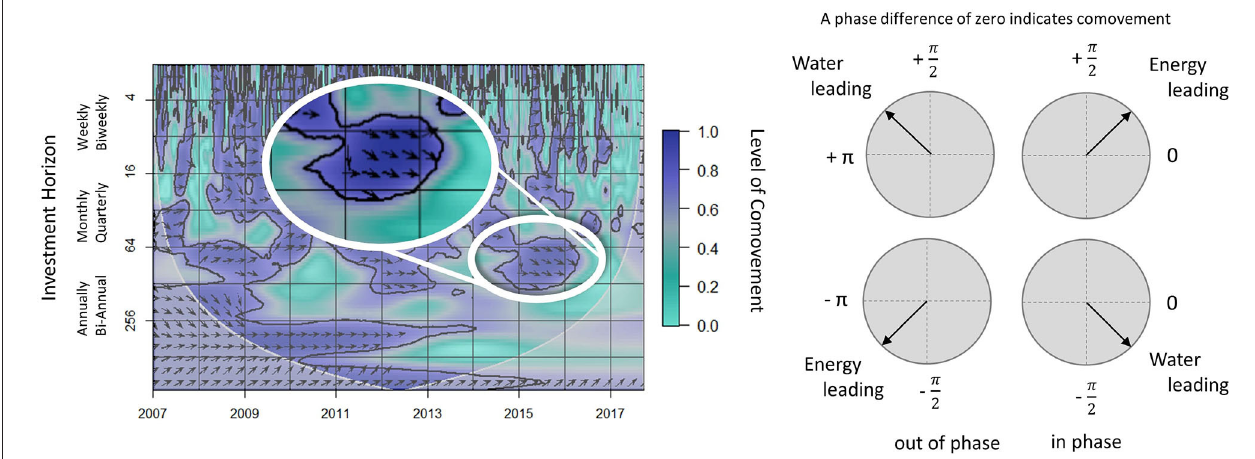
FIGURE 2 | The WSC of prices for water and energy (left) and phase change descriptions (right). The vertical axis shows investment horizons in days and the horizontal axis shows time in years. The darker purple the regions are (areas with arrows), the higher the level of comovement. The regions that are lined with black are regions of statistical significance at the 5% level estimated using multiple Monte Carlo randomizations. The white overlay defines the cone of influence. The arrows are an indication of phase movement (leading-lagging relationship) described in section 2.2.3 and visualized on the right side of this figure. See Gouhier et al. (2016) for more details.